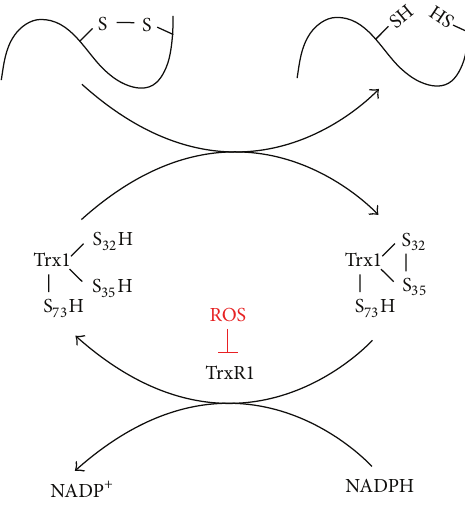
Figure 1: The proposed pathway for the accumulation of Trx-S 2 in RA-FLS. Under normal conditions, Trx1-(SH) 2 reduces disulfide bonds in its substrates to form free thiols, while Trx1-(SH) 2 is oxidized to Trx1-S 2 simultaneously. TrxR1 further converts the disulfide bonds in Trx1-S 2 to Trx1-(SH) 2 in the presence of NADPH. However, under elevated reactive oxygen species (ROS) in RA- FLS, the oxidized form of TrxR1 is accumulated, which reduces the activity of TrxR1 and causes the accumulation of Trx1-S 2 in